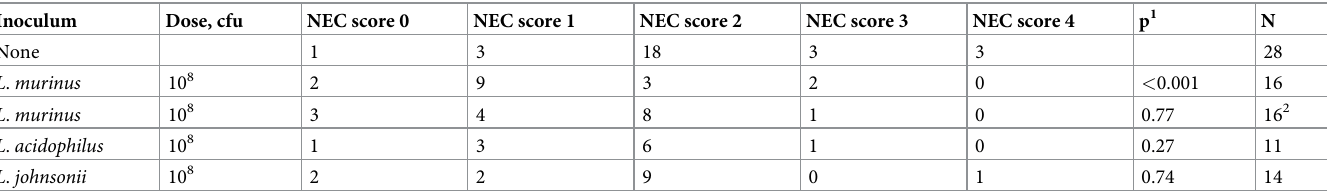
Table 2. Effects of inoculation with lactobacilli on NEC scores upon challenge with 10 6 cfu C . muytjensii .